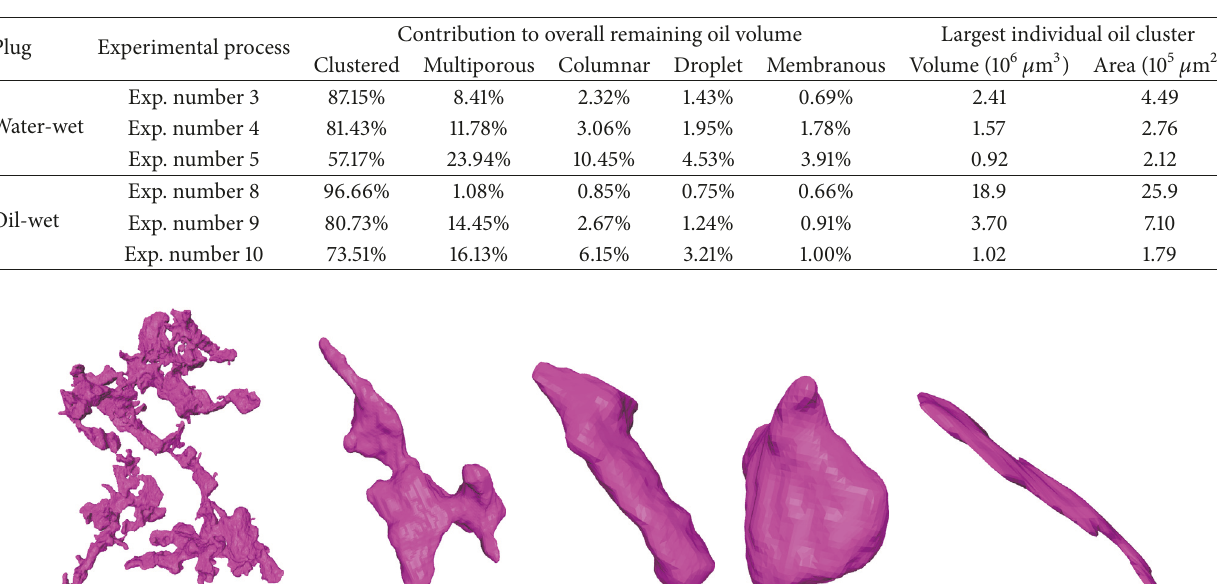
Table 3: Dynamic changes of each type of remaining oil during the water injection.